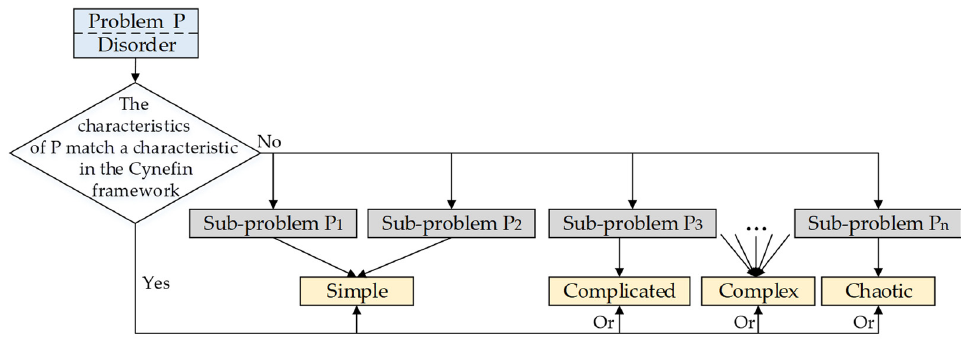
Figure 6. Disorder problem area splitting.